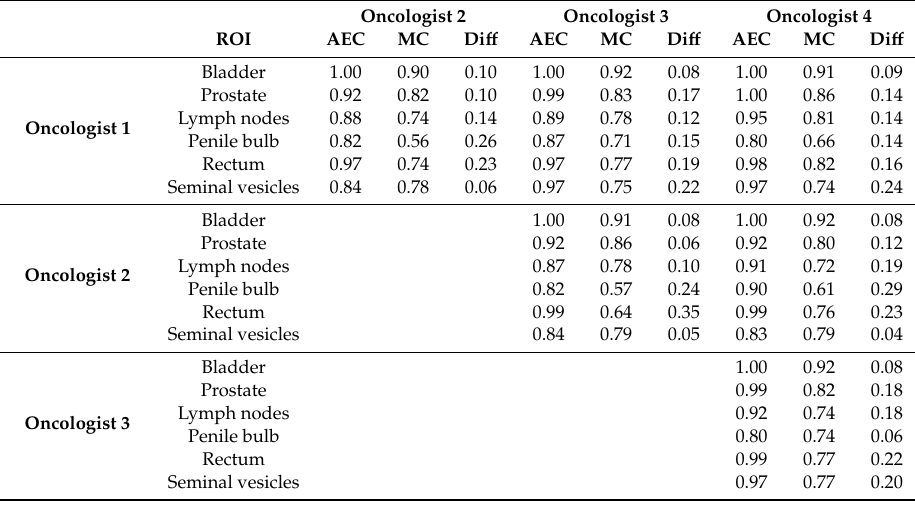
Table 2. Dice similarity coefficients (DSC) were evaluated between four oncologists for the same five patient data set for manual contouring (MC) and automated and edited contouring (AEC) method. Diff = DSC difference between AEC and MC methods (ROI: regions of interest).